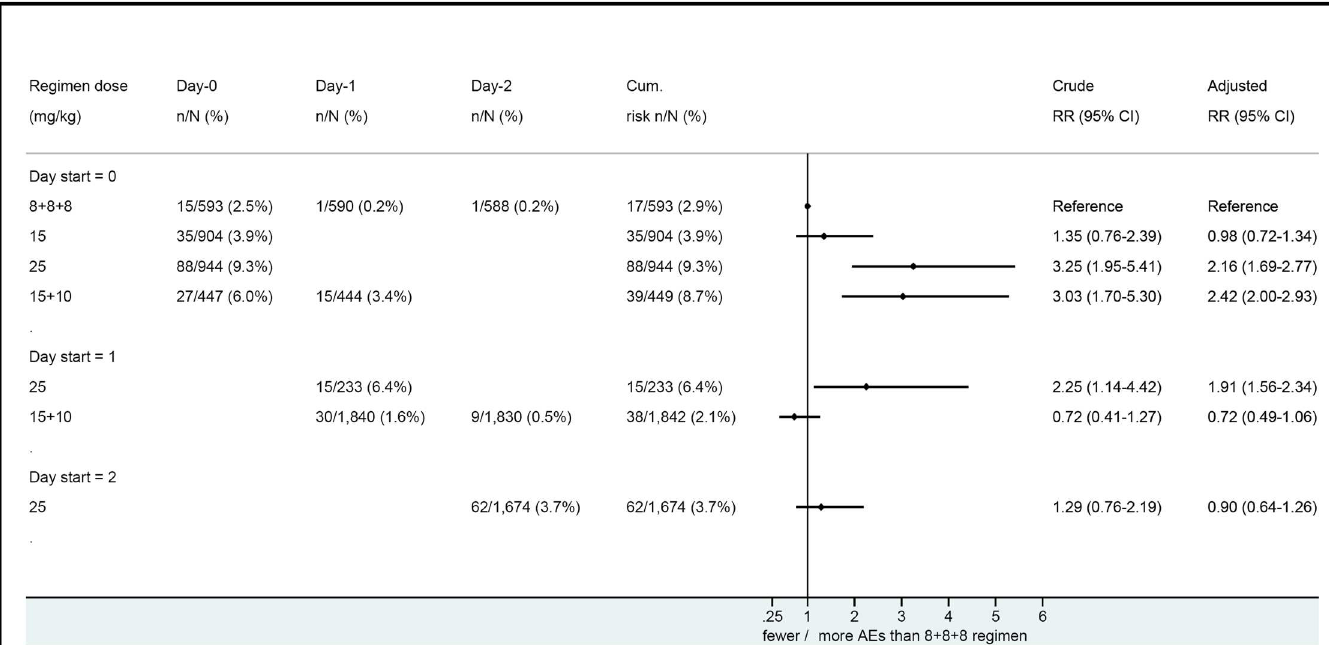
Fig 3. Forest plot of adjusted cumulative risk of early vomiting compared with the 8+8+8 treatment group (8 mg/kg MQ on three consecutive days). Adjusted analyseswere stratified by year and includedcovariatesfor age, sex, baselinehematocrit, fever at admission,baseline[log] parasitaemia and vomiting at admission; more specificallyto the latter, the occurrence of early vomiting on day 0 for day 1 risk estimates and the occurrence of early vomiting on day 1 for day 2 risk estimates. Cumulative risks were definedas any vomiting on any day within 1 hour of MQ treatment. The cumulative frequency for 8+8+8 was 17/593(for daily frequencies, see S1